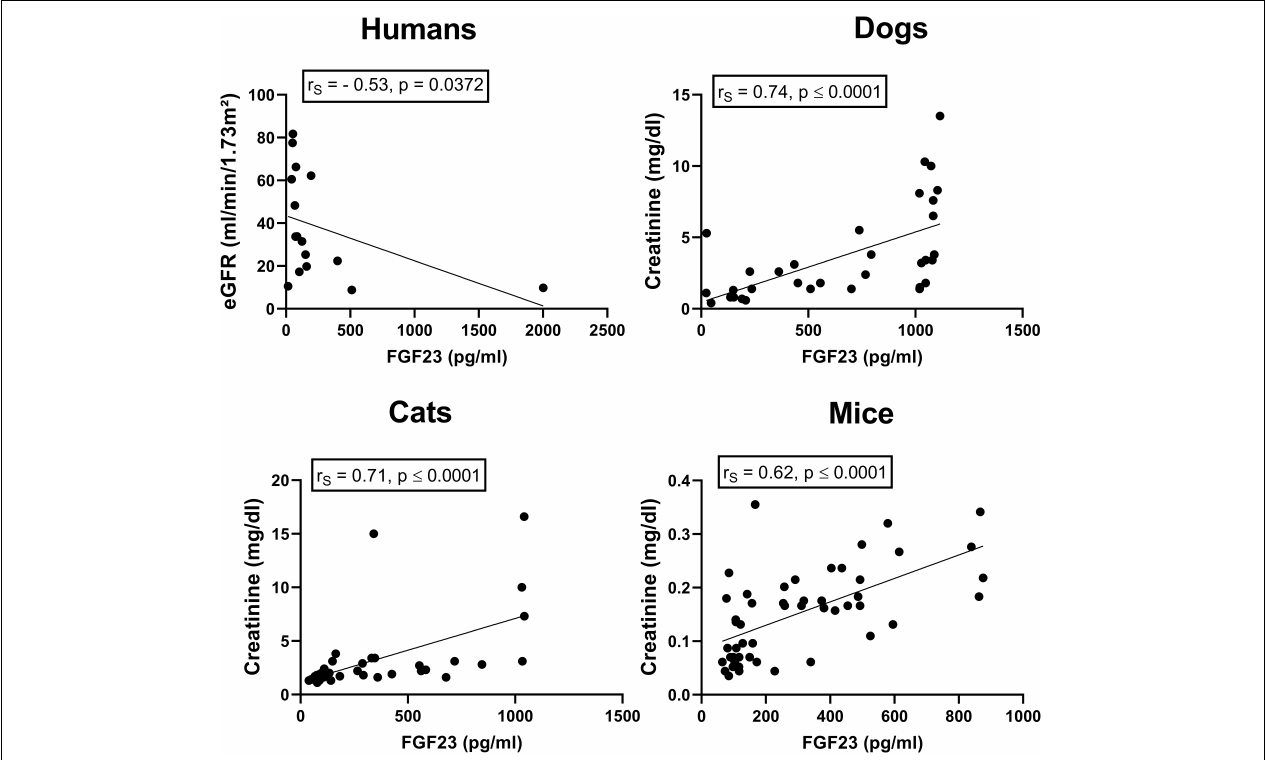
FIGURE 2 | Association between renal function and circulating intact FGF23 in human, feline, and canine CKD patients as well as in experimental murine CKD. Intact serum FGF23 and estimated glomerular filtration rate (eGFR) as well as serum creatinine levels are correlated in human ( n = 16), canine ( n = 34), and feline ( n = 38) CKD patients as well as in mice with experimentally induced CKD ( n = 50). Insets show Spearman rank correlation